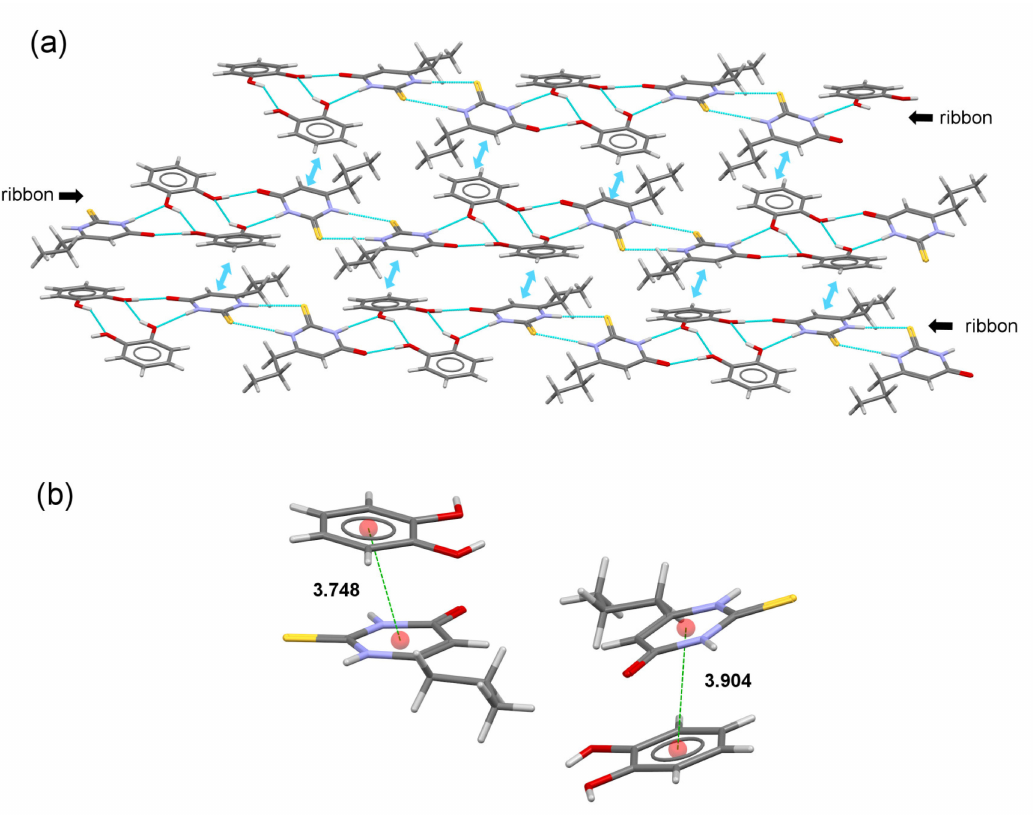
Figure 4. ( a ) Fragment of the 2D-layered structure built by association of ribbons by π , π -stacking interactions. ( b ) Details of the π , π -stacking interactions between PTU and CAT molecules (distances in Å).